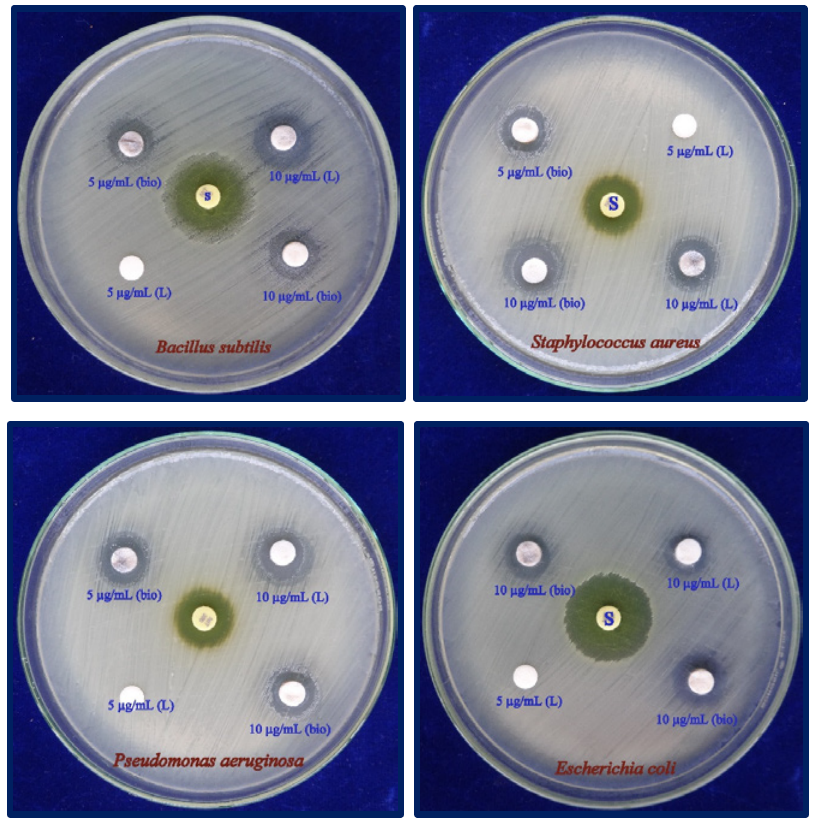
Fig. 9. Antibacterial activity of Acalypha indica leaf extract and biosynthesized ZnO nanoparticles against human pathogenic bacteria at different concentrations